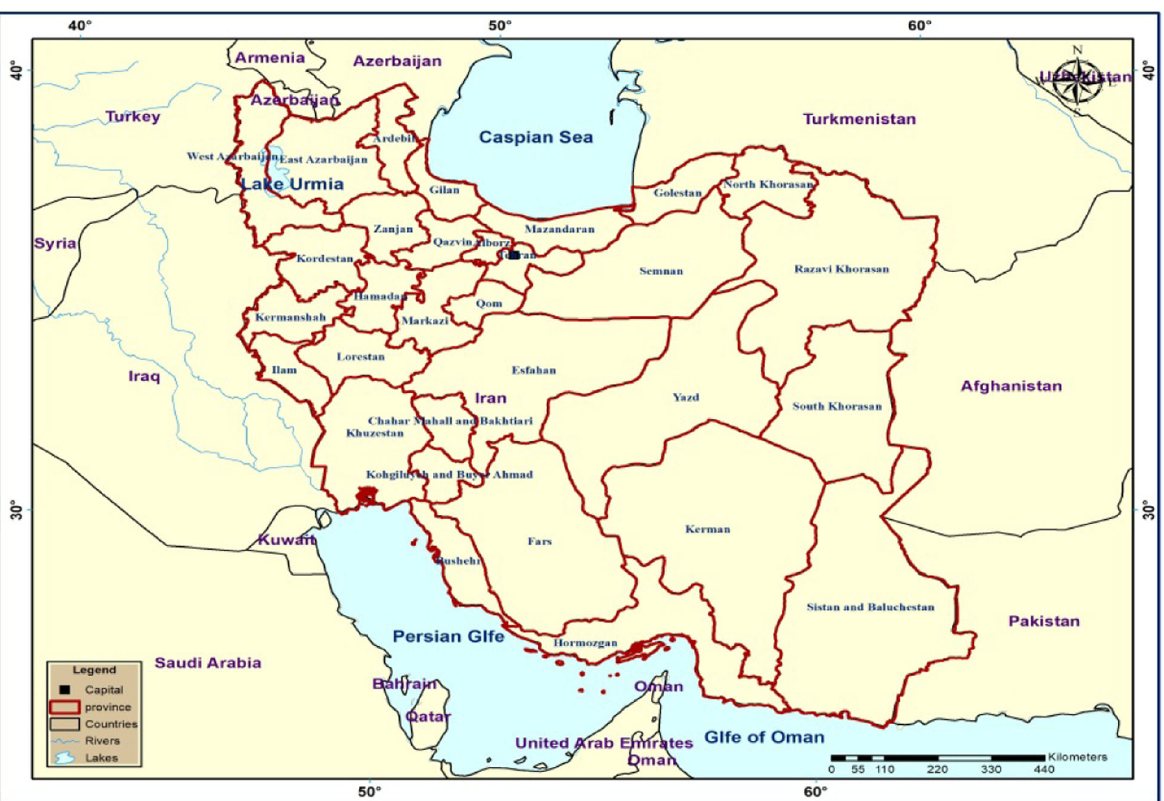
Fig. 1 The geographical position of Iran and its provinces. Figure shows the location of Iran in Southwest Asia. Most of Iranian provinces are concentrated in the western and northwestern regions. The urban population is also more concentrated in these provinces. Iran, one of the leading countries in Southwest Asia with a population of 83 million, has 31 provinces and shares border with 15 countries. Due to its geopolitical and geostrategic position, Iran is of geopolitical importance in the Middle East. The 2019 population density in Iran was 51 people per mm 2 (132 people per mi 2 ), calculated based on